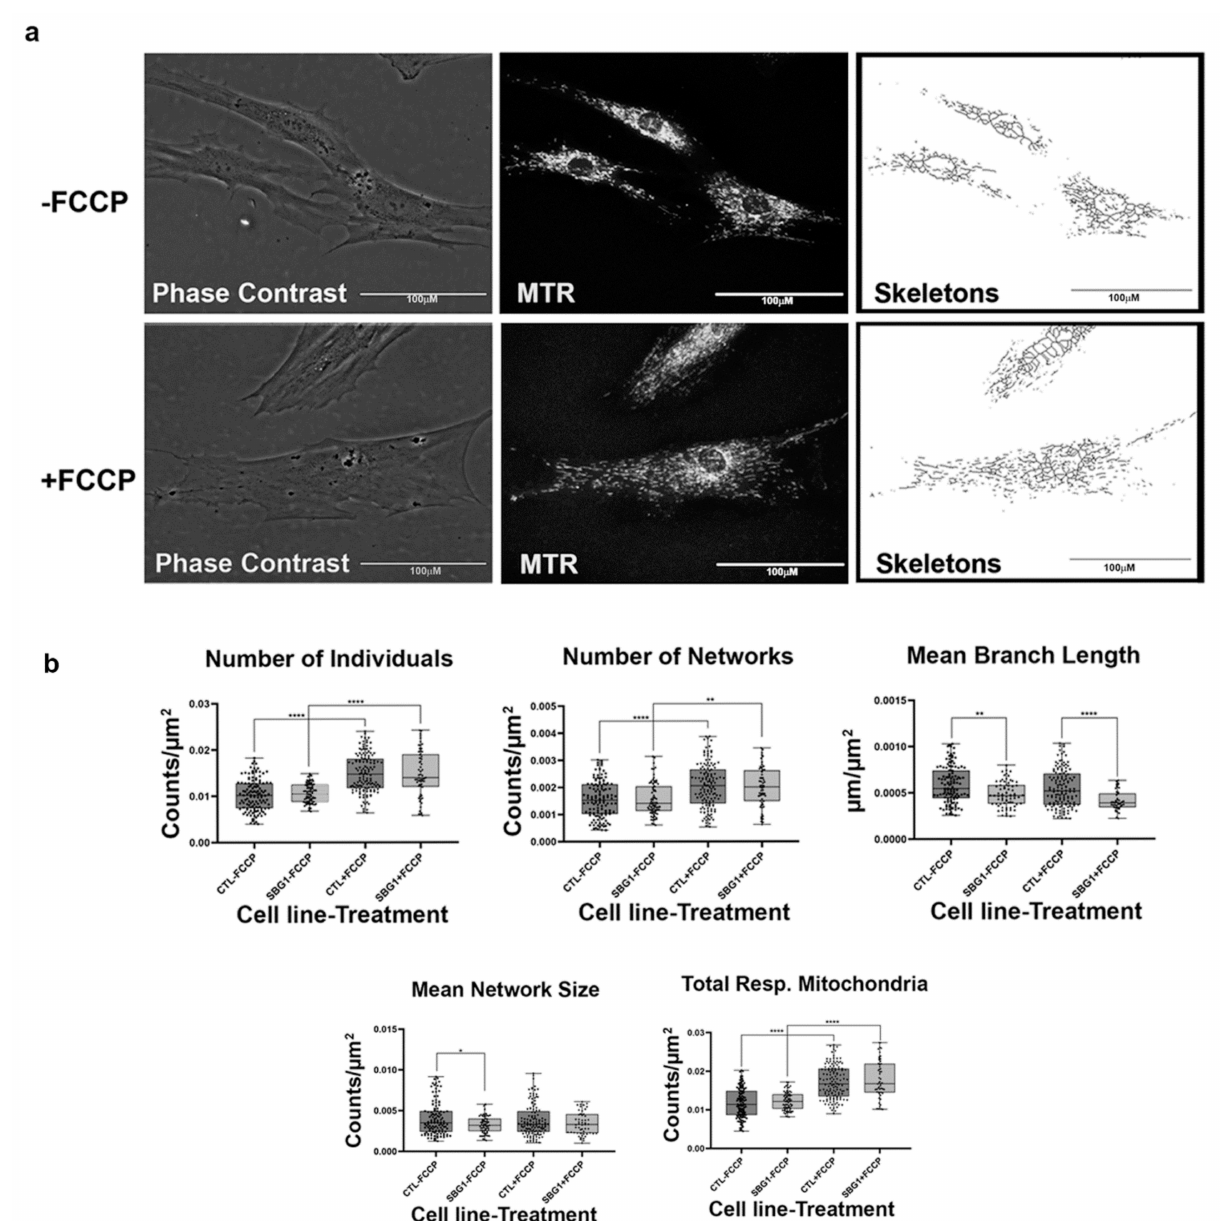
Figure 3. Mitochondrial morphology of SBG1 fibroblast in the absence and presence of FCCP. ( a ) Representative images of SBG1 fibroblast cell lines stained with MTR. The top images are phase contrast, RFP, and skeletonized images of SBG1 fibroblasts without FCCP treatment. The bottom images are phase contrast, RFP, and skeletonized images of SBG1 fibroblasts with FCCP treatment. ( b ) Although SBG1 cell lines have a comparable number of individual and networked mitochondria to control, the mitochondria in these lines are smaller. This is evident in the significant decrease in mean branch length and mean network size relative to control under basal conditions, without FCCP treatment. Treatment with FCCP resulted in mitochondrial fission, with SBG1 showing a response to FCCP similar to the healthy control. All data are representative of 10–14 images taken from three independent dishes per treatment group. The bars represent minimum and maximal values, and each black dot represents different data points. **** p < 0.0001, ** p < 0.01, * p < 0.05. Scale bar = 100 µ